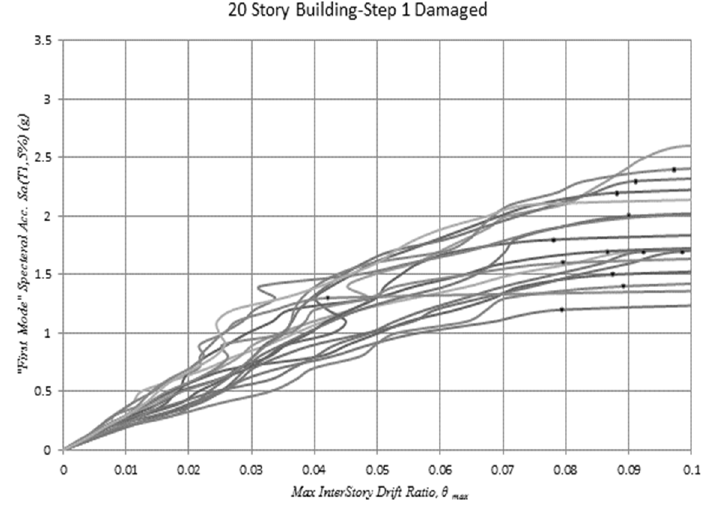
Figure 27. IDA curves obtained for a slightly damaged 20-story frame (by removing a beam and a column on the fifth floor).